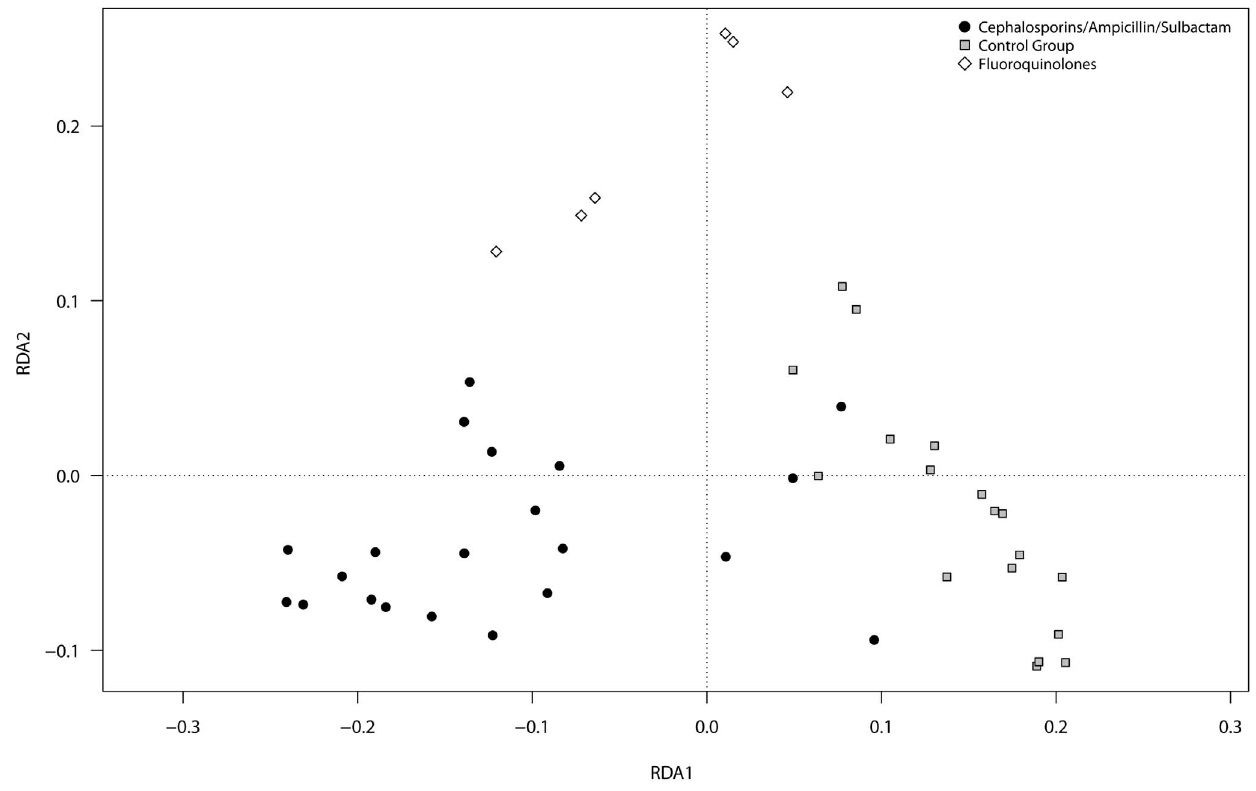
Figure 3. Graphical representation (distance plots) of the redundancy analysis (RDA) model of Hellinger-transformed OTU abundances. The model illustrate the relationship of gut microbes of healthy controls, individuals treated with ß-lactam antibiotic (Cephalosporins/ Ampicillin/Sulbactam) and individuals treated with fluoroquinolones at DNA level.